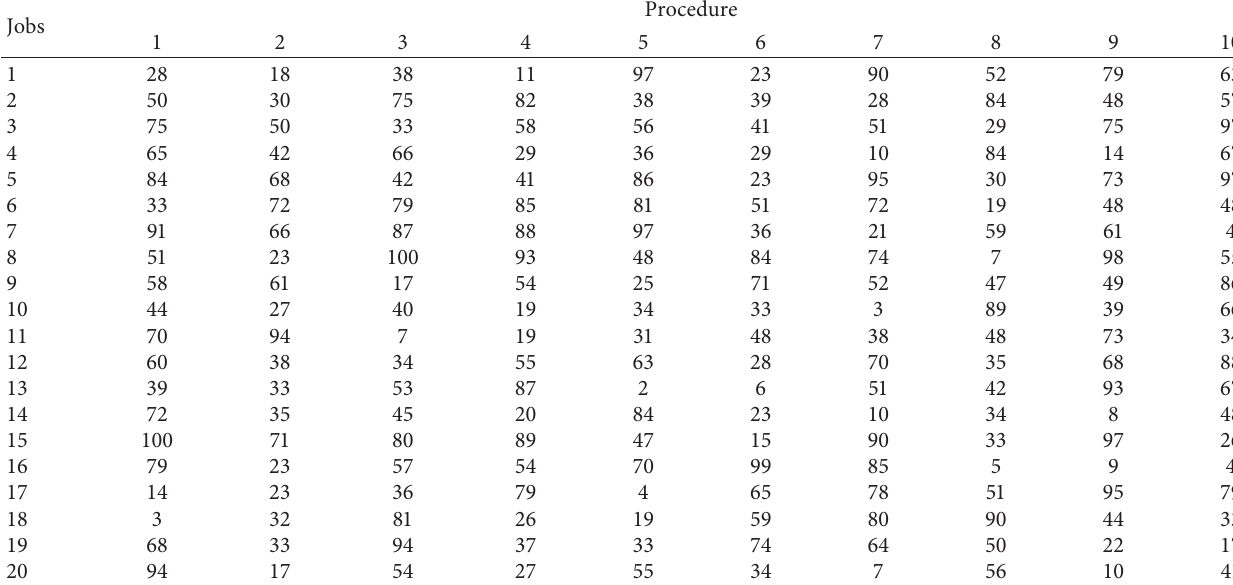
Table 1: Processing time matrix.